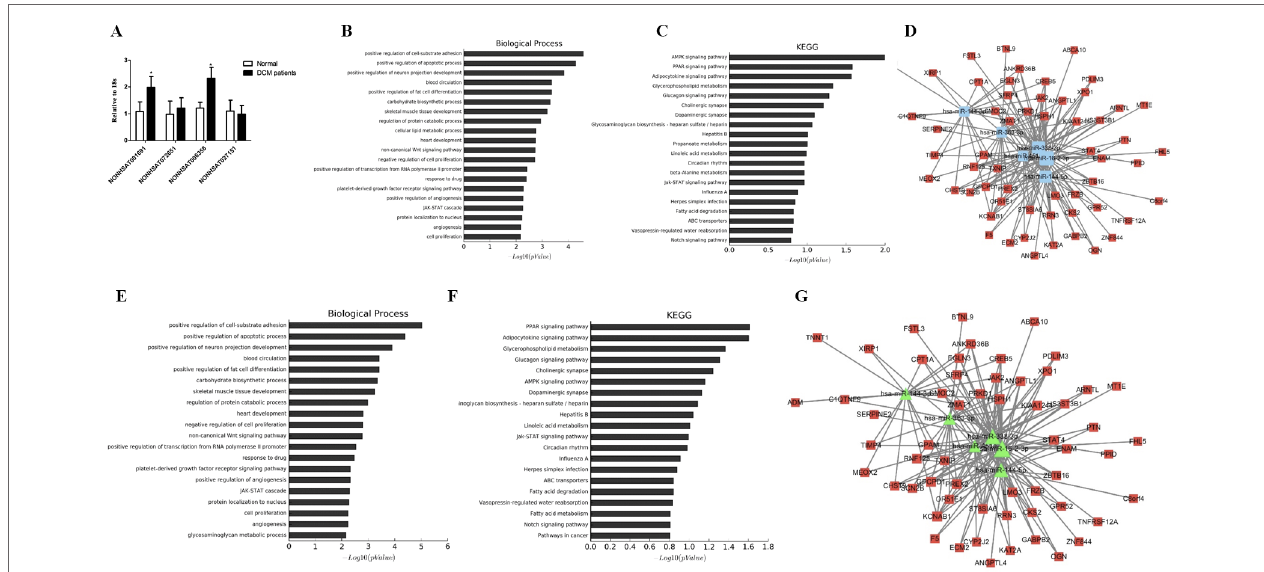
FIgURE 4 | Key lncRNA-miRNA-mRNA subnetwork. (A) . qRT-PCR analysis of lncRNA between DCM patients and healthy controls (n-3). (B, C) . Biological function and pathway analysis of differentially expressed mRNAs related with NONHSAT001691. (D) . NONHSAT001691 related miRNA-mRNA subnetwork. The blue represents miRNA and the red represents mRNA. (E, F) . Biological function and pathway analysis of differentially expressed mRNAs related with NONHSAT006358. (g) . NONHSAT006358 related miRNA-mRNA subnetwork. The triangle represents miRNA and the square represents mRNA. *, p < 0.05.